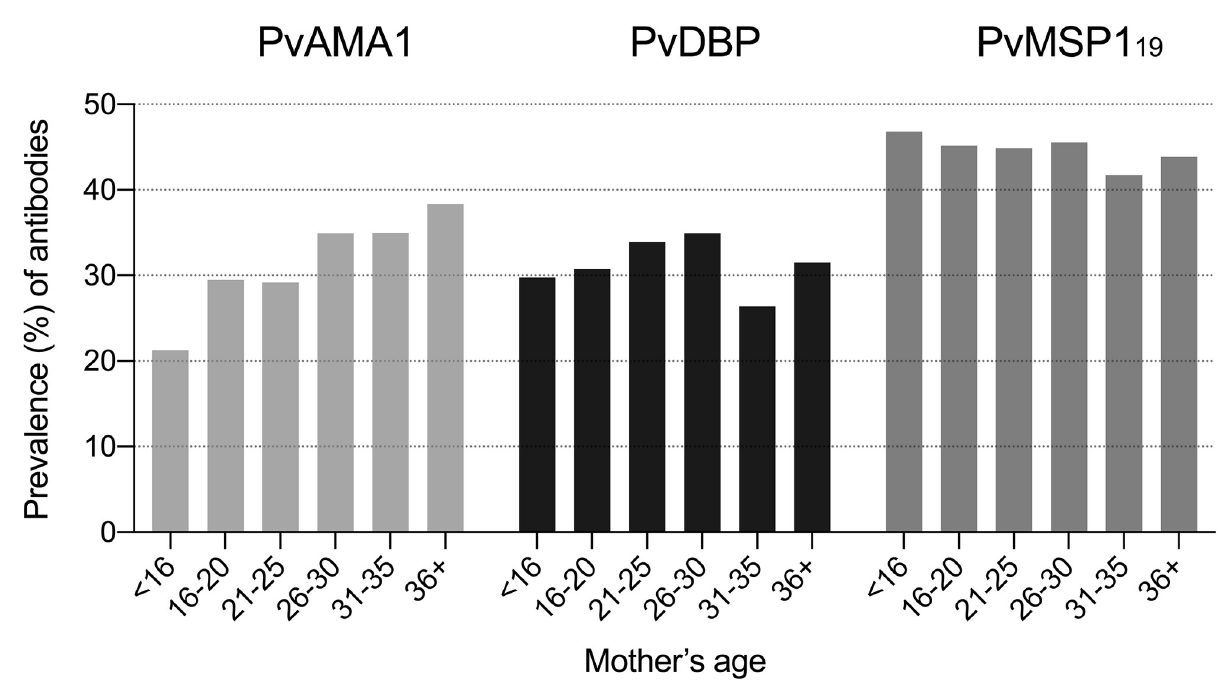
Fig 5. Age-related prevalence of maternal IgG antibodies to the blood-stage P . vivax antigens PvAMA1, PvDBP, and PvMSP1 19 in MINA-Brazil study participants. Numbers of tested samples per age group were: < 16 years, n = 47; 16–20 years, n = 312; 21–25 years, n = 274; 26–30 years, n = 226; 31–35 years, n = 163; and 36+ years, n = 73. Age-related differences in antibody prevalence were significant only for PvAMA-1 (Mantel-Haenszel χ 2 test for linear trend, P = 0.015).